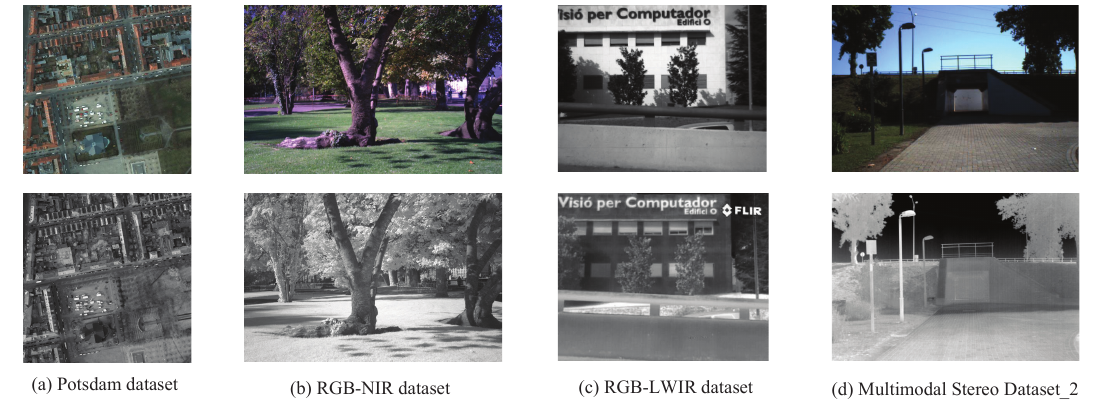
Figure 7. Examples from the data